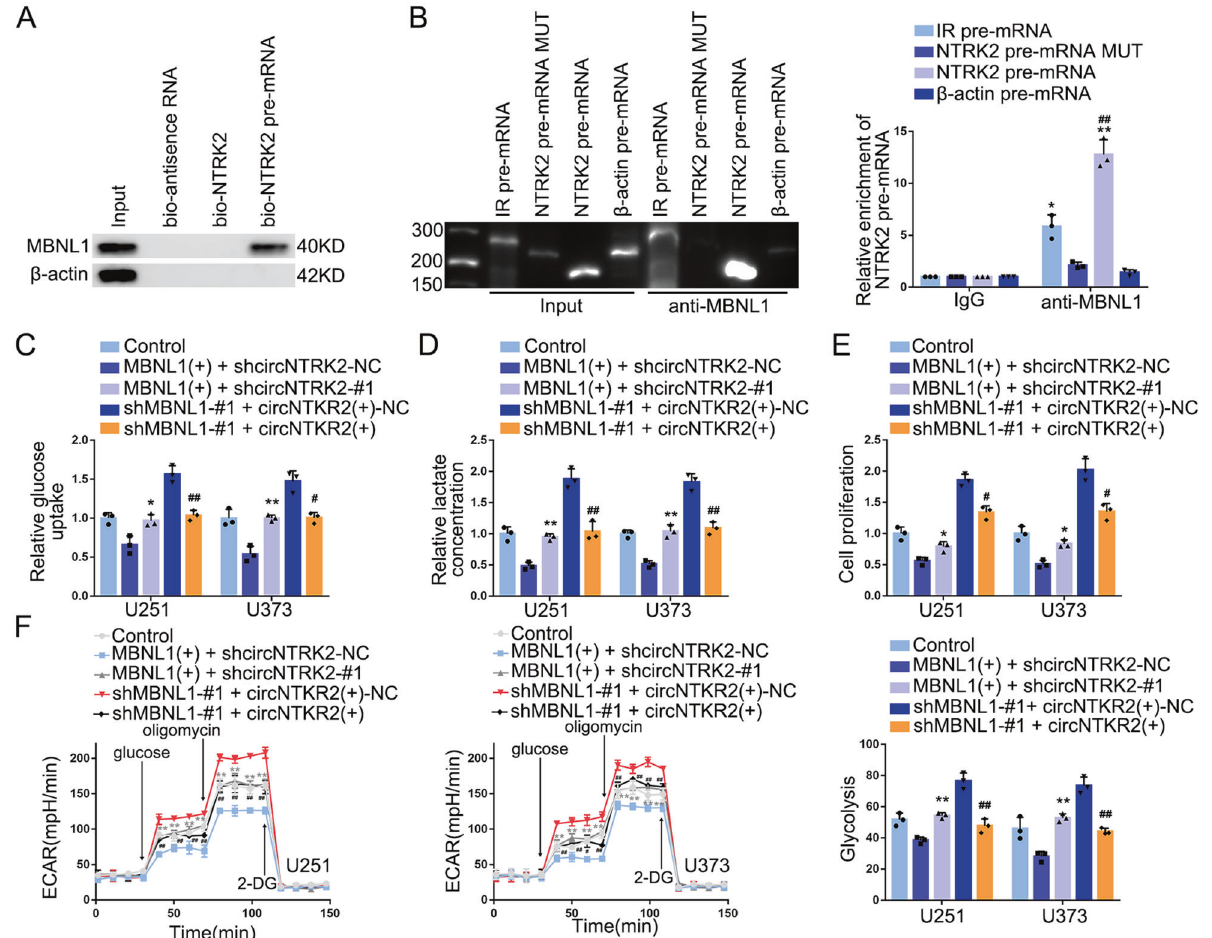
Fig. 3 MBNL1 promoted CircNTRK2 expression by binding to NTRK2 Pre-mRNA inhibiting glycolysis and proliferation in GBM cells. A The combination of MBNL1 and NTRK2 pre-mRNA was determined by RNA pull-down assays. MBNL1 and β -actin protein in immunoprecipitation with bio- NTRK2 pre-mRNA were detected via western blotting. Bio-antisense RNA was referred as negative control. B The relative enrichment of NTRK2 pre-mRNA in IgG and anti-MBNL1 group was detected by nascent RIP assay. IR pre-mRNA group was referred as positive control whereas β -actin pre-mRNA group as negative control. Data are presented as mean ± SD ( n = 3, each group). * P < 0.05, ** P < 0.01 compared with anti-MBNL1 β -actin pre-mRNA group; ## P < 0.01 compared with anti-MBNL1 NTRK2 pre-mRNA MUT group. C – E The reverse effect of circNTRK2 on MBNL1 in terms of glucose uptake, lactate production, and proliferation. Data are presented as mean ± SD ( n = 3, each group). * P < 0.05, ** P < 0.01 compared with MBNL1( + ) + shcircNTRK2-NC group; # P < 0.05, ## P < 0.01 compared with shMBNL1-#1 + circNTRK2( + )-NC group. F The reverse effect of circNTRK2 on MBNL1 in terms of glycolysis and glycolysis levels in each ECAR group were analyzed. Data are presented as mean ± SD ( n = 3, each group). ** P < 0.01 compared with MBNL1( + ) + shcircNTRK2-NC group; ## P < 0.01 compared with shMBNL1-#1 + circNTRK2( + )-NC group. Glycolytic capacity and glycolytic reserve in each ECAR group were analyzed (see Supplementary Fig. 3C,